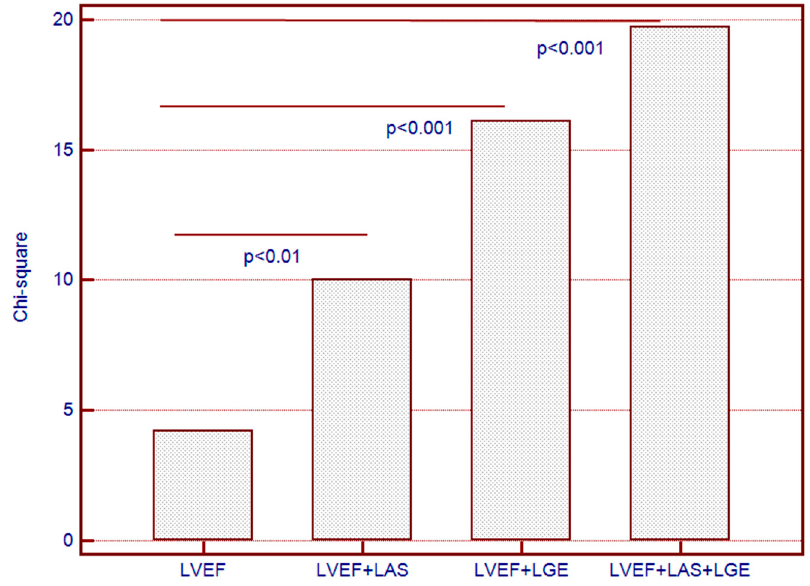
Figure 4. Incremental predictive value of longitudinal axis strain (LAS) and late gadolinium enhancement (LGE) added to left ventricular ejection fraction (LVEF) for the combined end-point in AS patients.